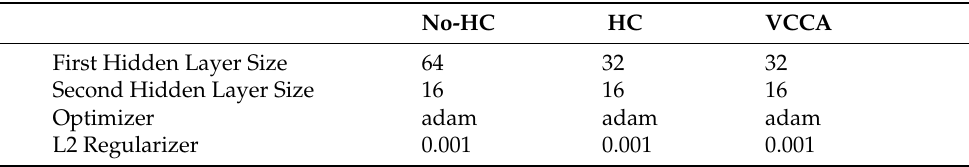
Table 14. The hyperparameters used for the Dataset